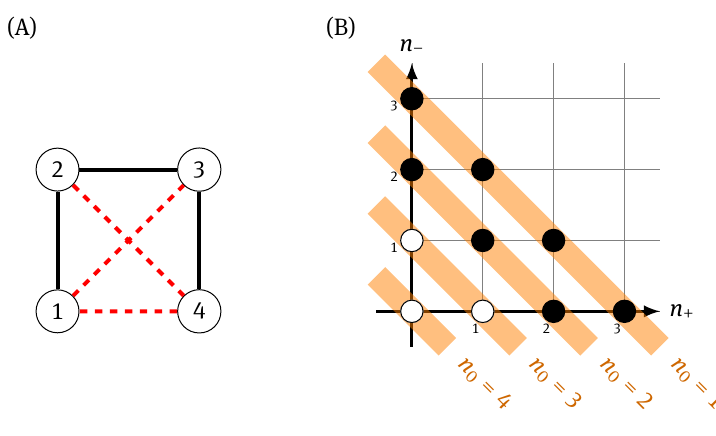
Figure 8: (A) The only (up to isomorphism) signed graph G on 4 vertices with c ± = 1 . (B) Black dots represent all achievable Laplacian inertias by G and the white dots are the ones that cannot be achieved by a consistent weighting of G